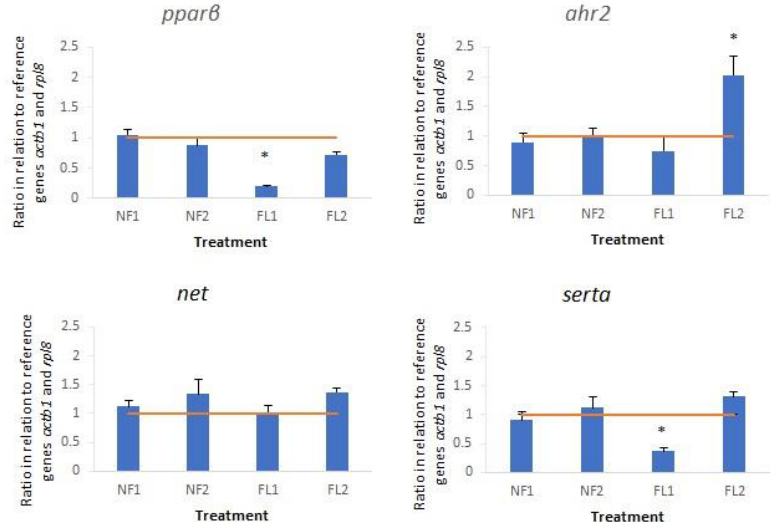
Figure 5. Relative expression of genes from cluster g. The stars indicate statistically significant differences ( p < 0.05) relative to the solvent control (from the results of the ANOVA on normalised expression, Table S2, Supplementary material). The horizontal line (x = 1) indicates the baseline expression for the solvent control.